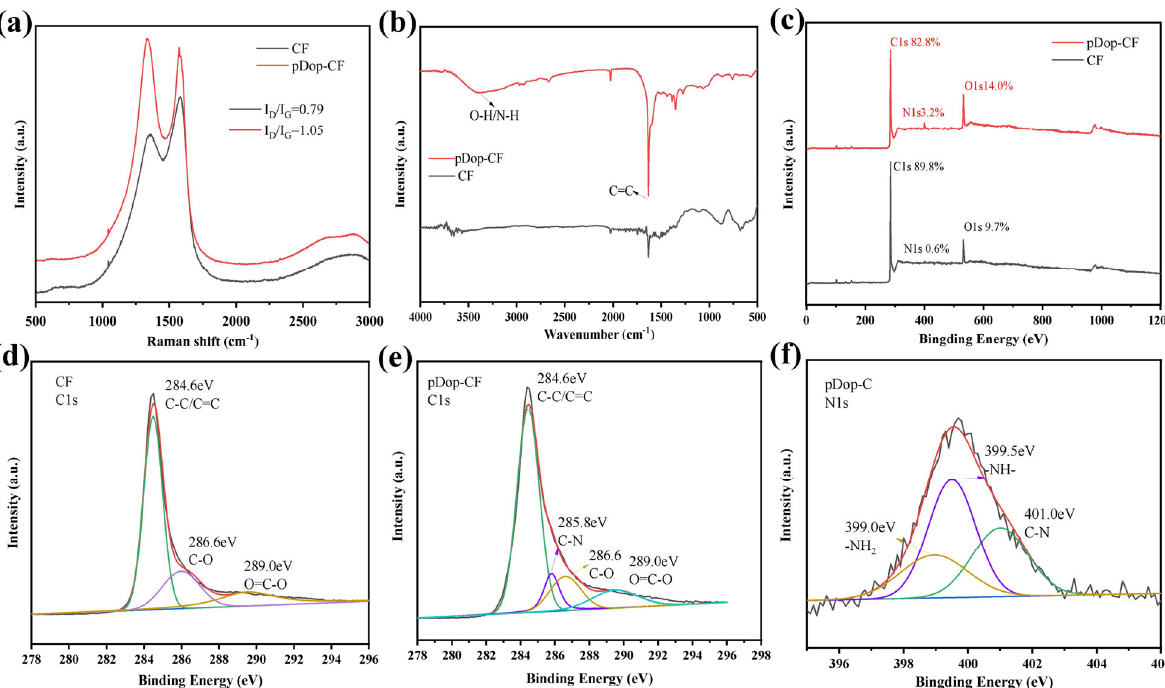
Figure 3. ( a ) Raman spectra, ( b ) FTIR spectra, and ( c ) XPS curves of CF and pDop ‐ CF. ( d ) C1s pro